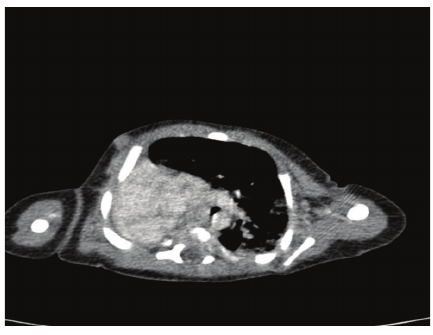
Figure 2: Absence of right main bronchus and right lung on CT scan.